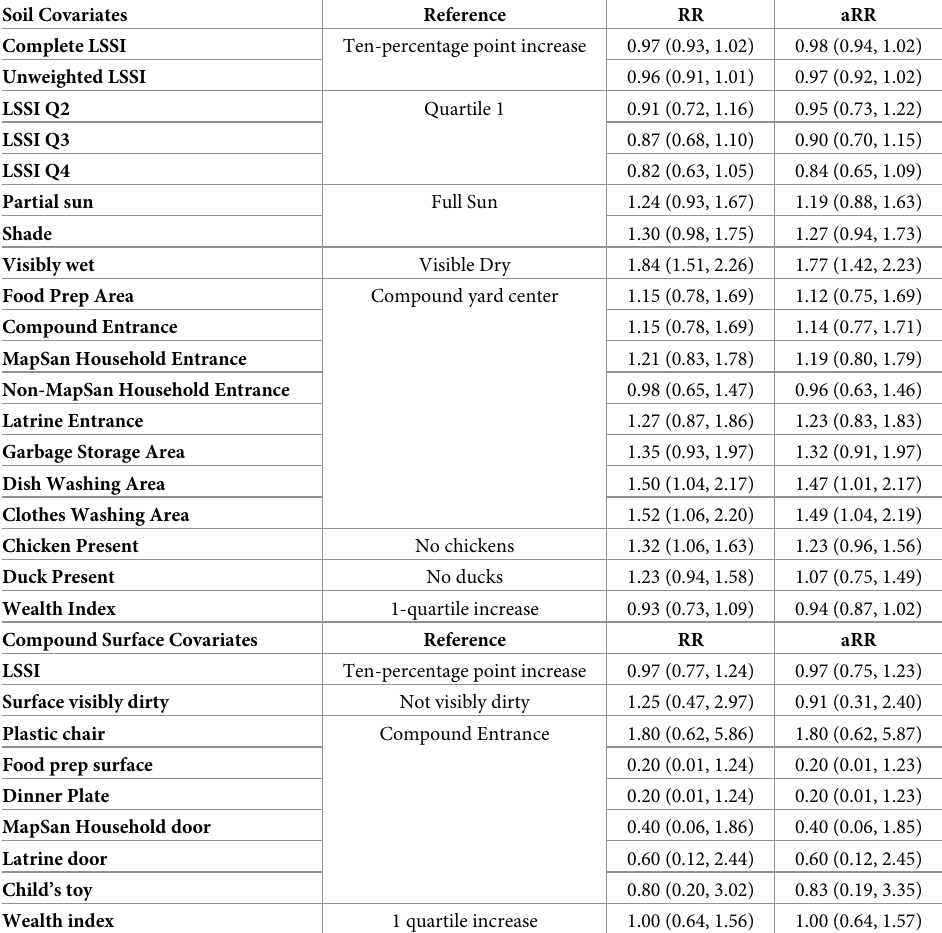
Table 4. Logistic regression models using detect/non-detect E . coli as the response variable.